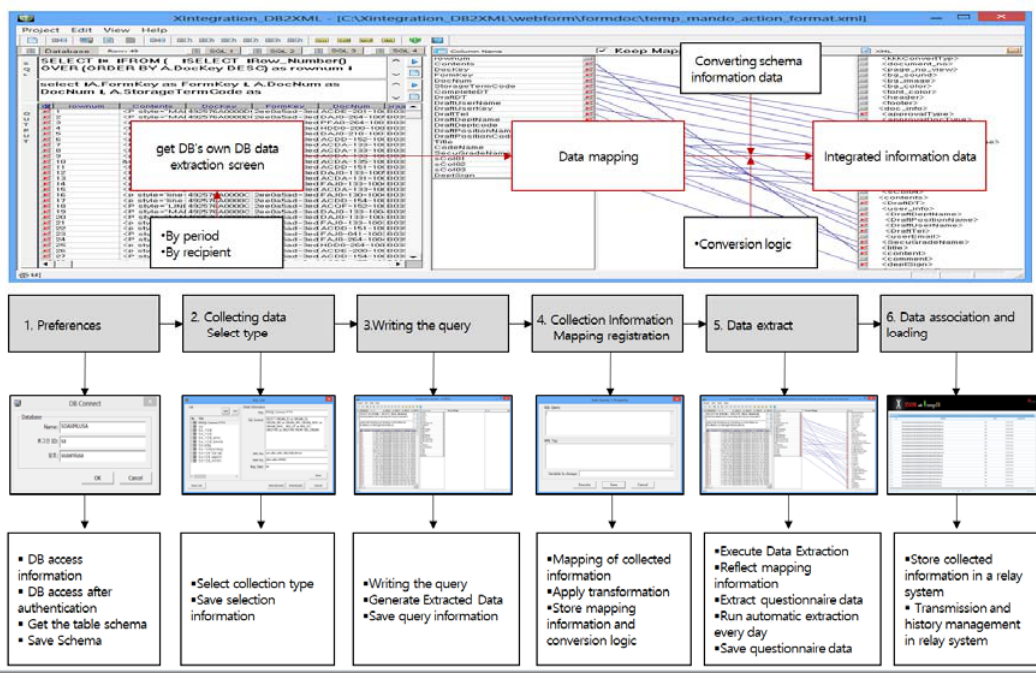
Figure 25. Rainbowchain architecture. In this study, as a solution for security threats, which are a barrier to the expansion of the smart grid, this study proposes a smart grid Rainbowchain verification method using Blockchain that can be operated at a low cost and with more efficiency than the existing system. Also, it models Rainbowchain for test device verification, and it confirms the possibility of the application of Blockchain to the smart grid. Blockchain has been studied continuously since its inception, and application cases appear in various areas. While more time may be necessary to expand Blockchain technology due to technical